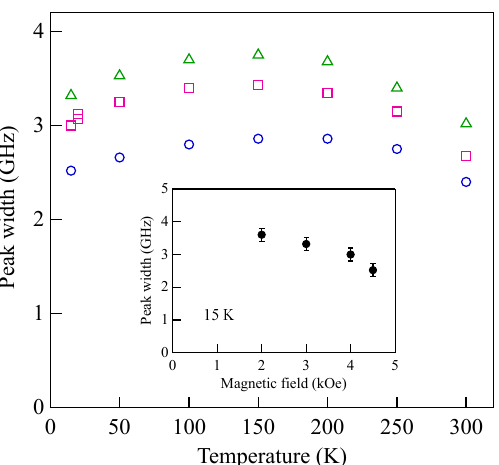
Figure 39. The peak width Γ /2 π as a function of temperature at H = 3.0 kOe ( Δ ), 4.0 kOe ( □ ), and 4.5 kOe ( ○ ). The inset shows a magnetic field dependence of the peak widths at 15 K. [108] The peak width clearly depends on both temperature T and the magnetic field H